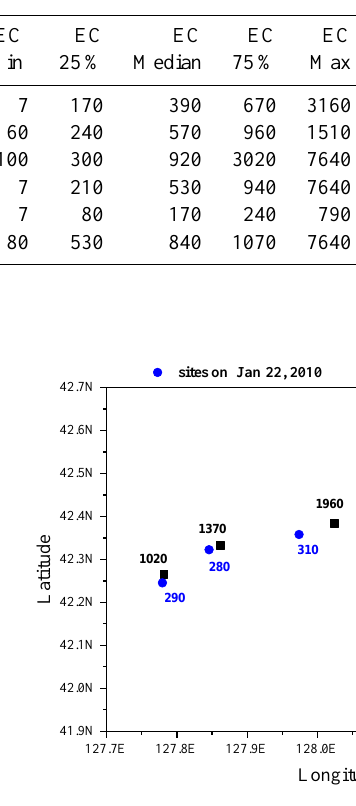
Table 1. Summary of statistical EC concentrations (ngg − 1 ) in snow at Changbai station.